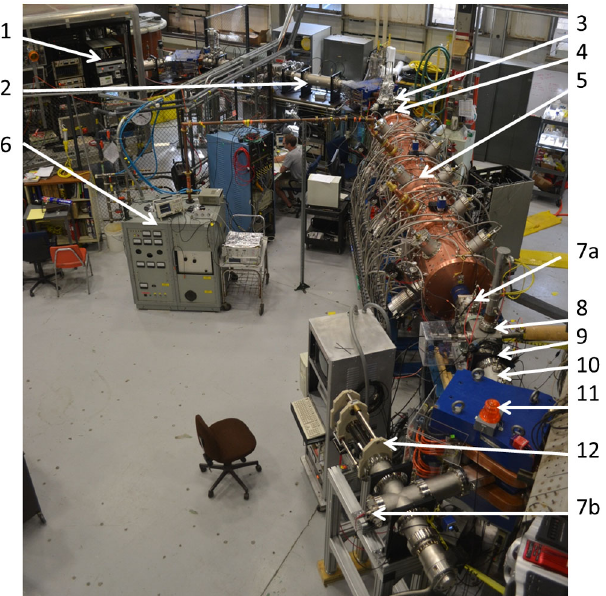
FIG. 13. General view of the RFQ test area. 1—All permanent magnet ECRIS installed on HV platform; 2—LEBT; 3—pepper- pot emittance probe; 4—matching quadrupole triplet; 5—RFQ; 6 —rf amplifier; 7a, 7b—water-cooled Faraday cup; 8—bunch shape monitor; 9—rotating wire scanner; 10—electrostatic dou- blet; 11—70 (cid:4) bending magnet; 12—water-cooled movable hori- zontal jaw slits.